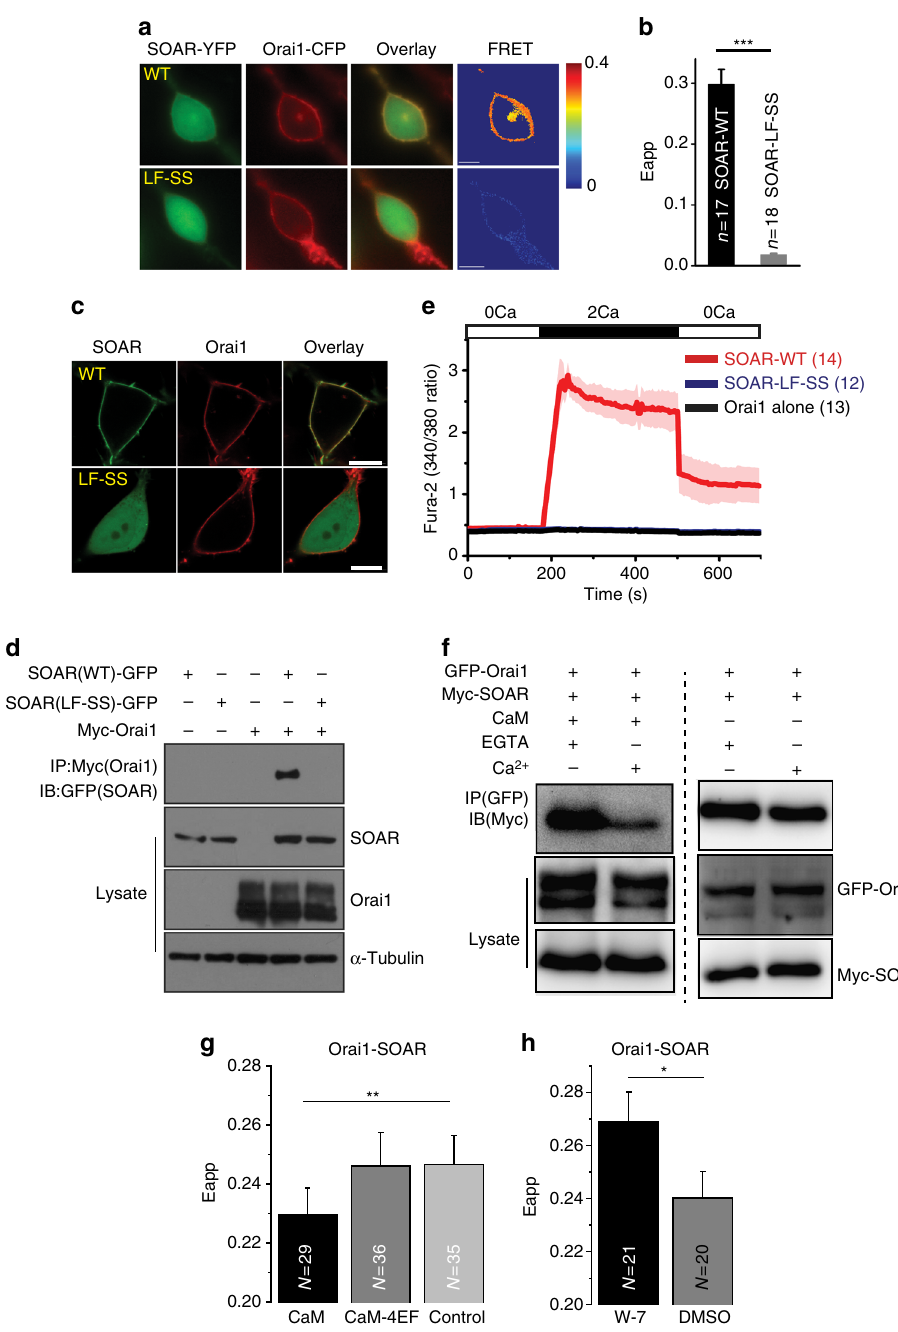
Fig. 4 Ca 2+ -CaM dissociates the SOAR – Orai1 complex. a , b Resting FRET was measured between Orai1-CFP and SOAR (WT or mutant)-YFP on PM of HEK Orai1-CFP stable cells. The cells were in 0 mM extracellular calcium Ringer ’ s buffer. Scale bars are 10 μ m. c Confocal images of live HEK293T cells transfected with SOAR-GFP (WT or mutant) and Cherry-Orai1. Scale bars are 10 μ m. d Western blot analysis of co-immunoprecipitated SOAR-GFP (WT or mutant) with Myc-Orai1. e Ca 2+ in fl ux in HEK293T cells co-expressing Cherry-Orai1 and SOAR-YFP WT or mutant. f Western blot analysis of competitive binding of the SOAR – Orai1 complex in the presence or absence of Ca 2+ -CaM. g Steady-state FRET between Orai1-CFP and YFP-SOAR co-expressed with CaM or CaM-4EF mutant on PM of HEK293T cells. FRET values were measured after 2 mM extracellular Ca 2+ was added. h Steady-state FRET between Orai1-CFP and YFP-SOAR on the PM of HEK293T cells that were pretreated with 30 μ M W-7 or DMSO control for 30 min. FRET values were measured after 2 mM extracellular Ca 2+ was added. Numbers of cells that were analyzed are indicated. * P < 0.05, ** P < 0.01 (unpaired Student ’ s t -test). Error bars denote STIM1 – LF-SS (Fig. 6a, lower panel). In cells that co-express STIM1 exists as a dimer in the resting state, and Ca 2+ depletion Orai1, after thapsigargin stimulation, the STIM1 WT formed from ER store induces further oligomerization 2, 46 . The STIM1 – LF-SS mutant did not form puncta, thus suggesting that puncta that were co-localized with Orai1 near the PM. The this mutant is unable to self-oligomerize after store depletion. To mutant STIM1 – LF-SS neither changed distribution nor co- further examine this hypothesis, we used FRET microscopy localized with Orai1 (Fig. 6b).